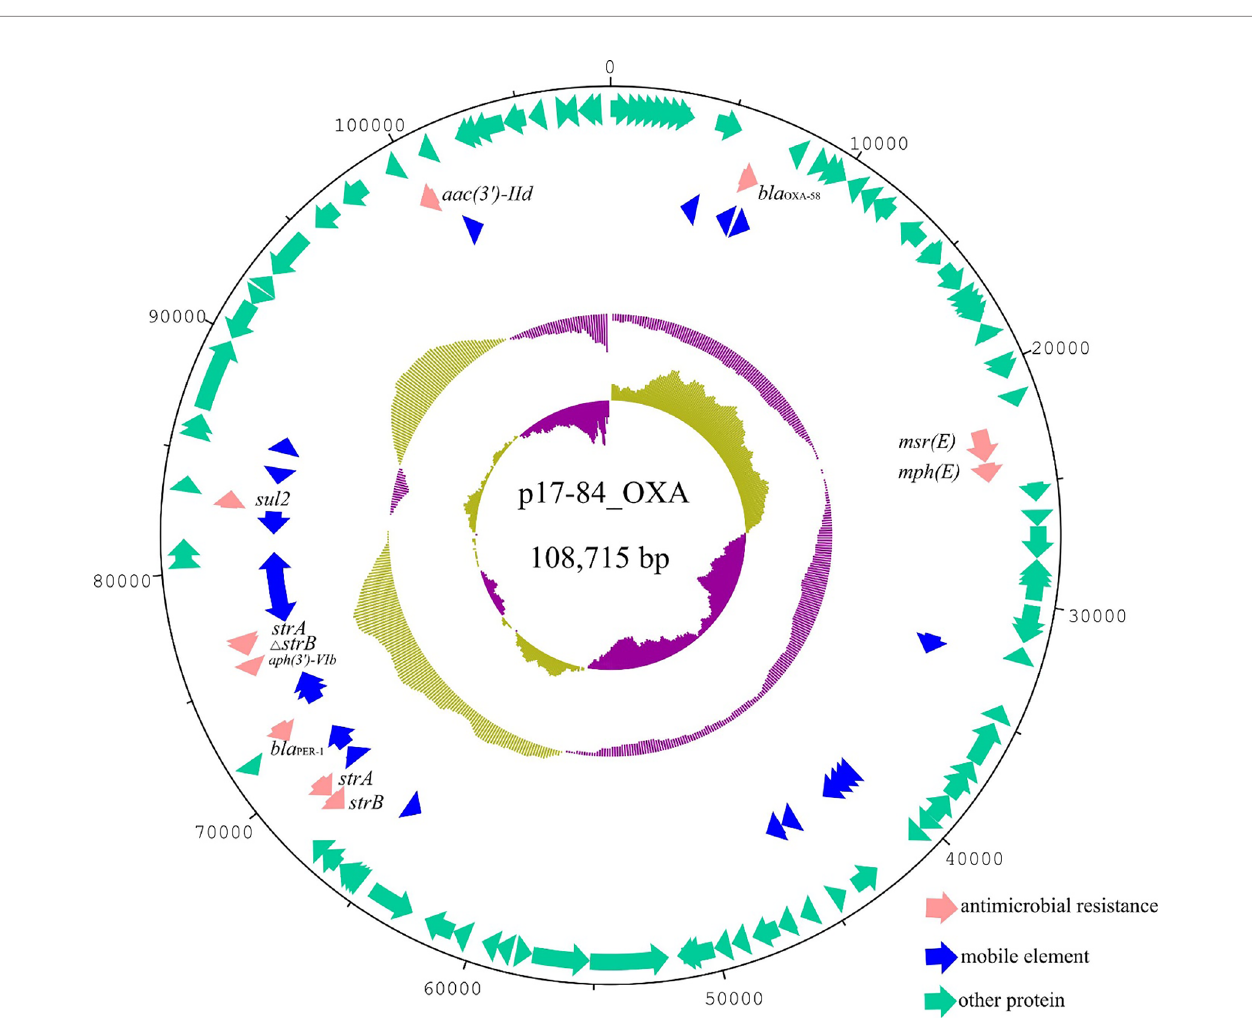
FIGURE 1 | Circular plasmid map of p17-84_OXA. Pink, blue, and green arrows indicated the antimicrobial resistance genes, mobile elements and other ORFs, respectively. Antimicrobial resistance genes carried by the plasmid were